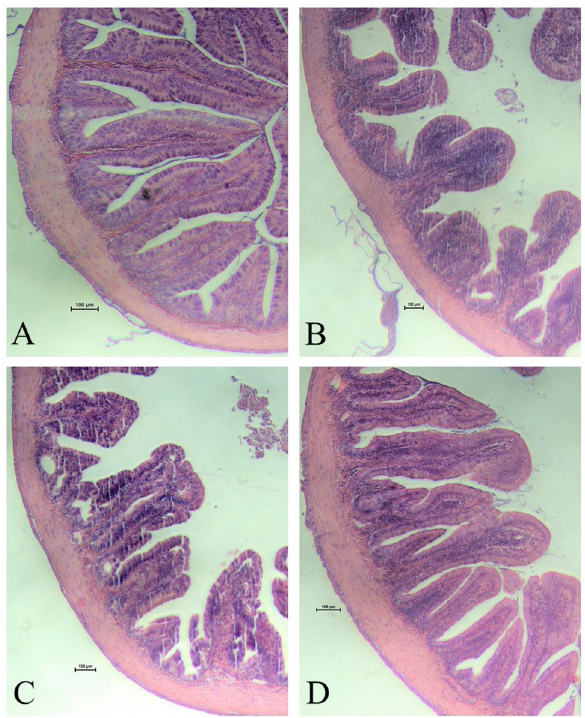
Figure 4. Cross-section of distal intestine samples. Histological samples of distal intestines from largemouth bass. (A) ( +) Control; (B) (−) control; (C) non-programmed; (D)